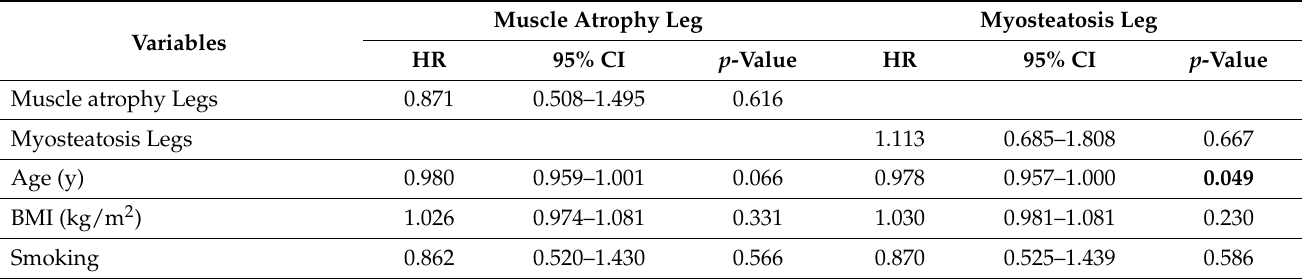
Table 5. Multivariable Cox proportional hazards model for muscle atrophy and myosteatosis for reintervention free survival in PAD